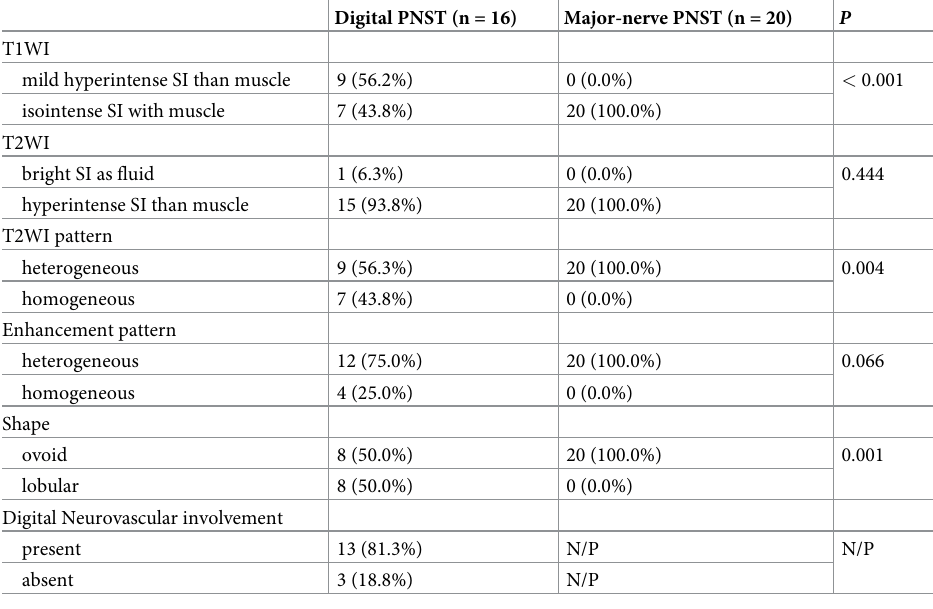
Table 3. Detailed MRI findings of digital